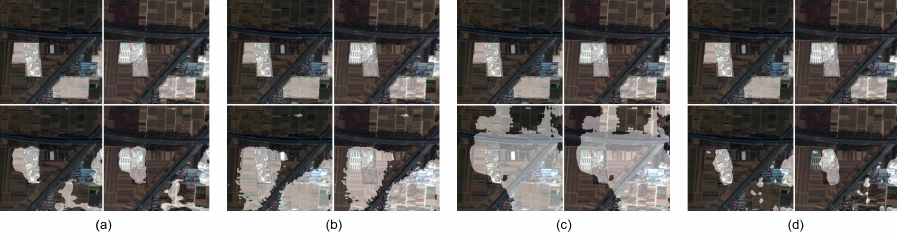
Figure 10. Visualization results of the proposed method and other sematic segmentation models. ( a ) Our model. ( b ) DeeplabV1. ( c ) DeeplabV2. ( d )